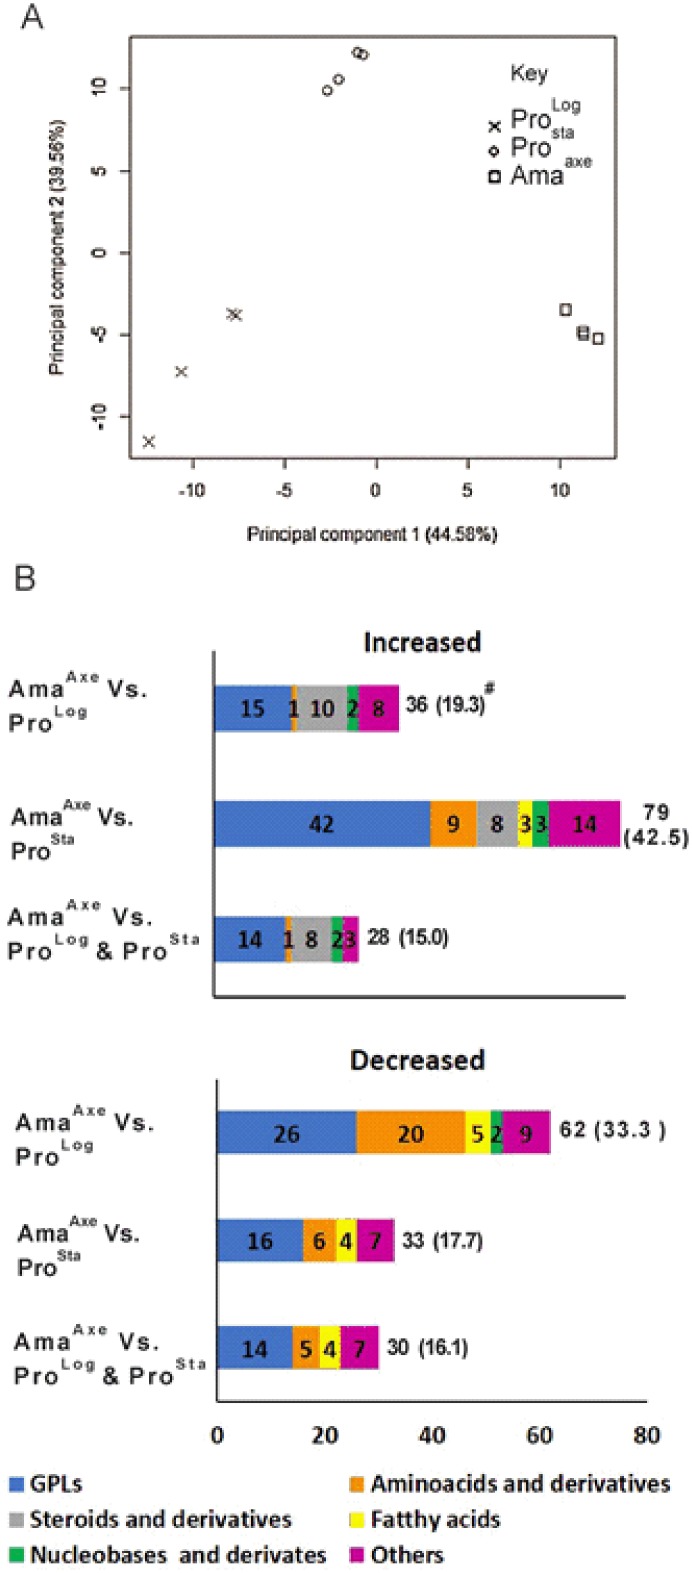
Metabolic profile in promastigotes and axenic amastigotes.A, Principal component analysis (PCA) distinguishing the metabolome of three growth stages in L (V.) braziliensis. PCA shows unsupervised clustering based on the quantitative information of all 186 putatively identified metabolites. B, Number of metabolites, organized by main metabolic pathways, with significantly increased (> 2 fold; t-test, P< 0.05) or decreased (<0.5 fold; t-test, P< 0.05) levels in Amaaxe in comparison to Prolog, Prosta or both. For each growth stage, four biological replicates were included. The detailed results of the 186 metabolites can be found in the supporting information (S2 Table). # Total number and percentage (calculated on the base of 186 identified metabolites).